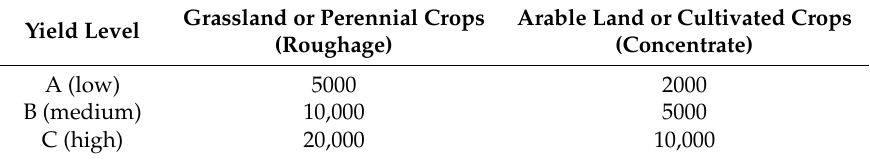
Table 5. Assumed plant yields for further calculations (kg dry matter per ha and